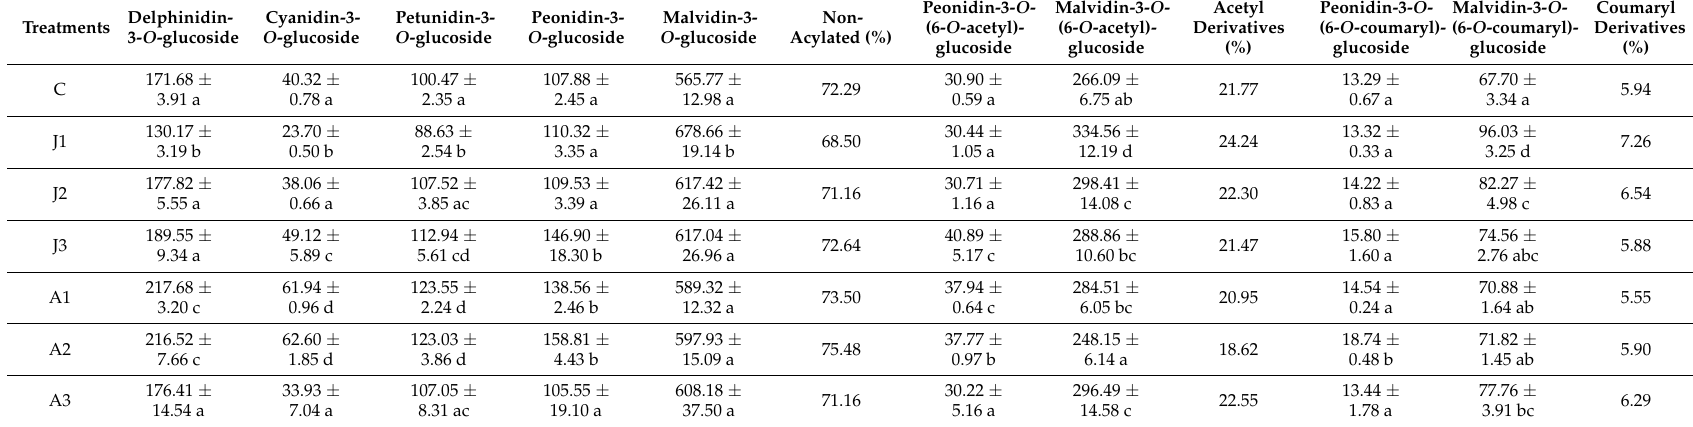
Table 2. Individual anthocyanin content of Cabernet Sauvignon berry skins after different treatments (mean ± SD, n = 3, mg · L − 1 ).